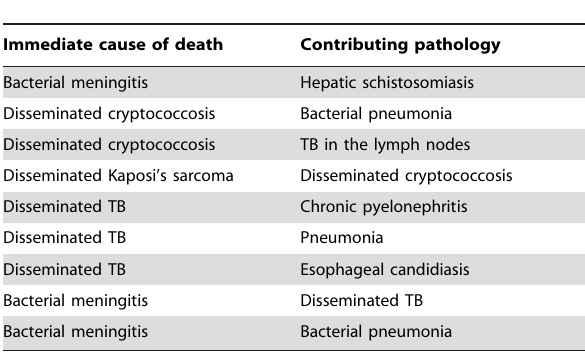
Table 3. Dual infections among HIV-infected